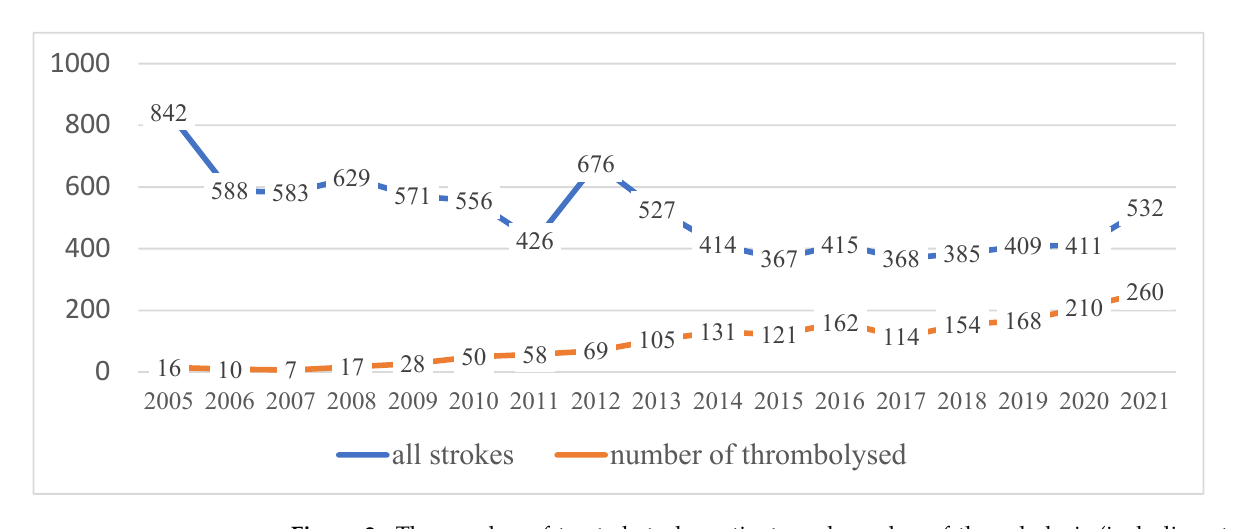
Figure 2. The number of treated stroke patients and number of thrombolysis (including stroke mimics) since 2005.